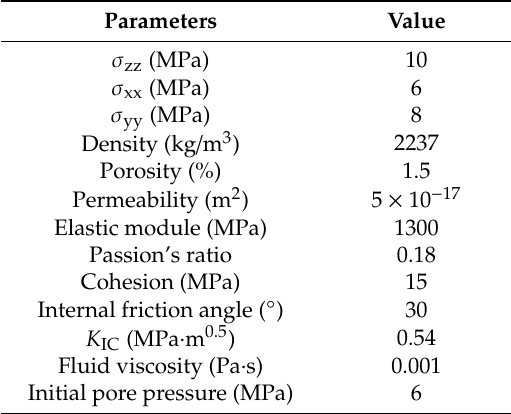
Figure 15. Initial stress field of the numerical model.